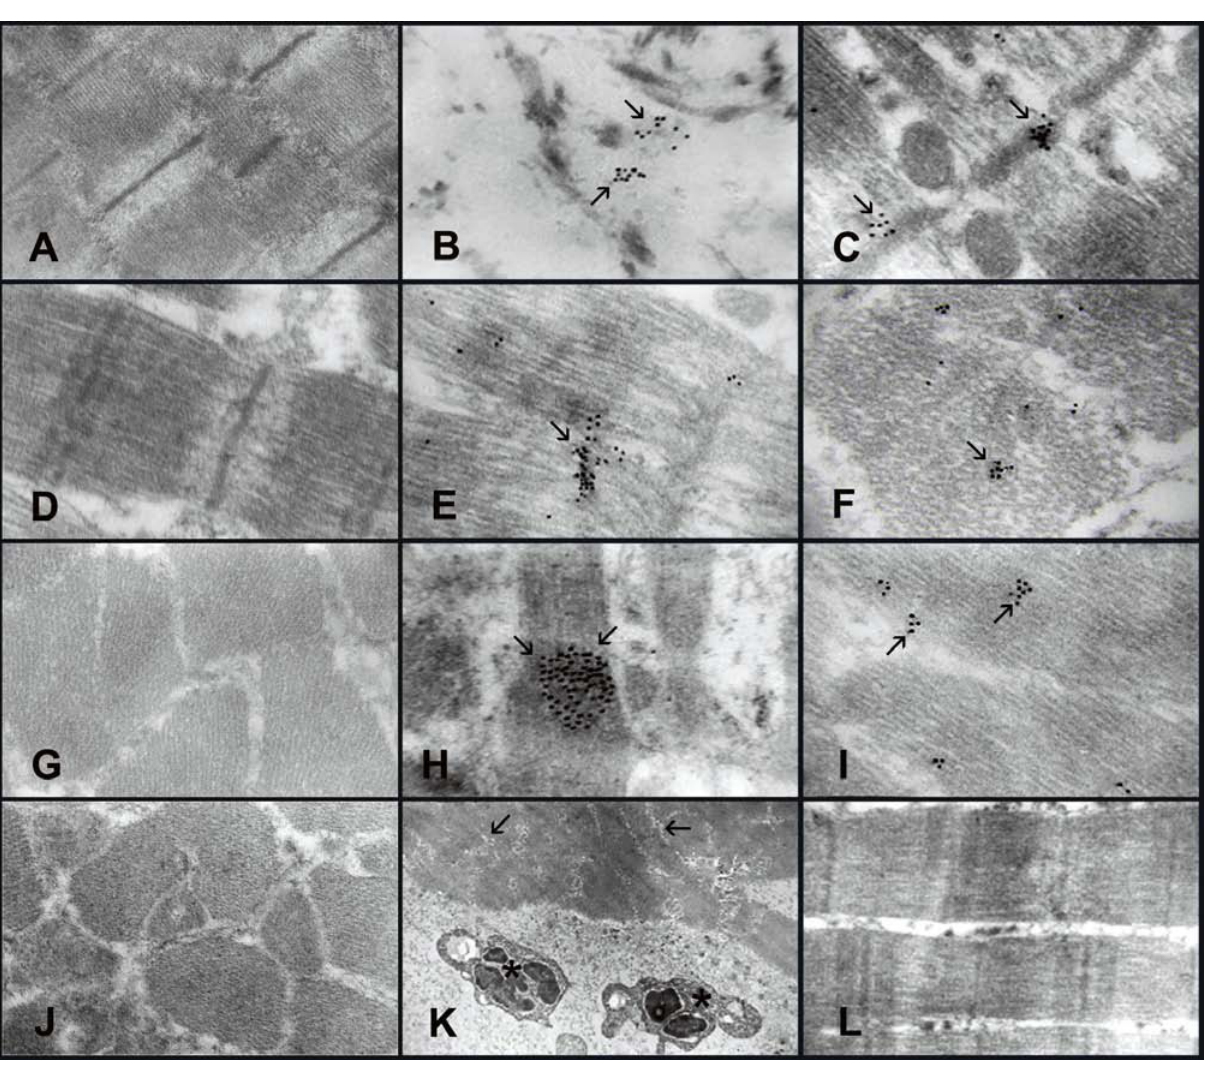
Figure 2. Immunodetection of neuwiedase on skeletal muscle tissue. ( A ) Fifteen minutes after PBS injection (magnification – 30,000x). ( B , C ) Fifteen minutes after neuwiedase injection (magnification – 85,000x): ( B ) immunopositive reaction (arrows) in the connective tissue and (arrows, C ) specific labeling in Z line. ( D ) Thirty minutes after PBS injection (magnification – 40,000x). ( E , F ) Thirty minutes after neuwiedase injection (magnification – 85,000x): (arrows, E ) labeling in the I-band and (arrows, F ) labeling among filaments. ( G ) One hour after PBS injection (magnification – 40,000x). ( H , I ) One hour after neuwiedase injection (magnification – 85,000x): immunopositive reaction at the A-band (arrows). ( J ) Three hours after PBS injection (magnification – 40,000x). ( K ) Three hours after neuwiedase injection (magnification – 45,000x): mitochondrial swelling in the myofibrils (arrows) and inflammatory cells (*). ( L ) Control reaction with irrelevant antibody (rabbit anti- Toxoplasma gondii ) (magnification –